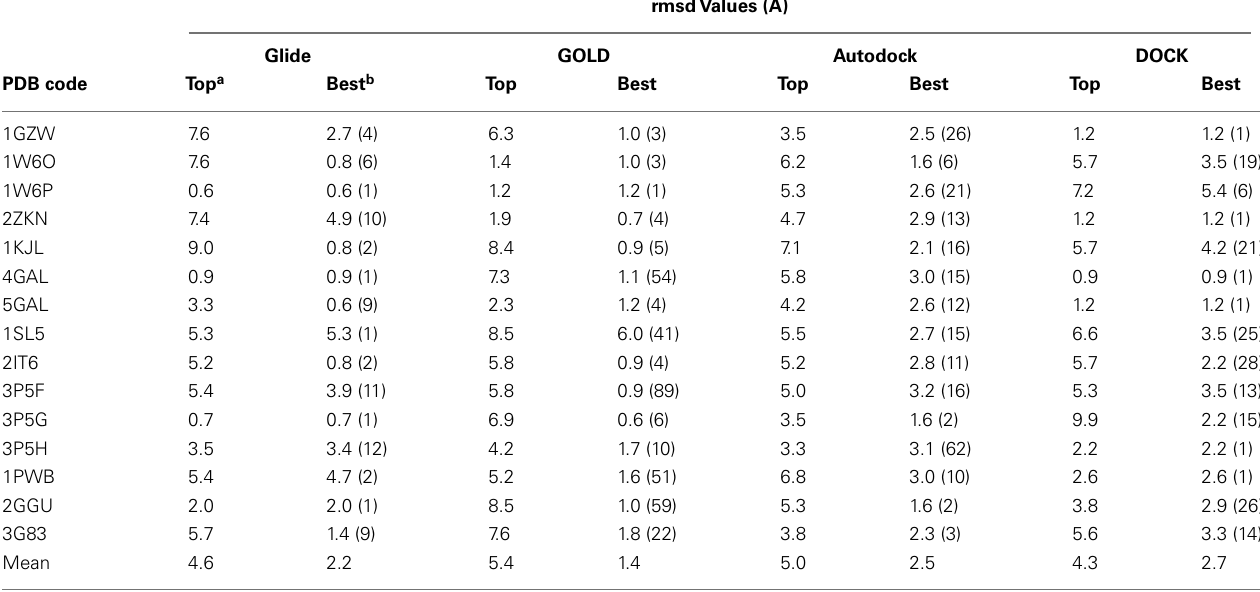
Table 2 | Cognate docking performance for the test set.